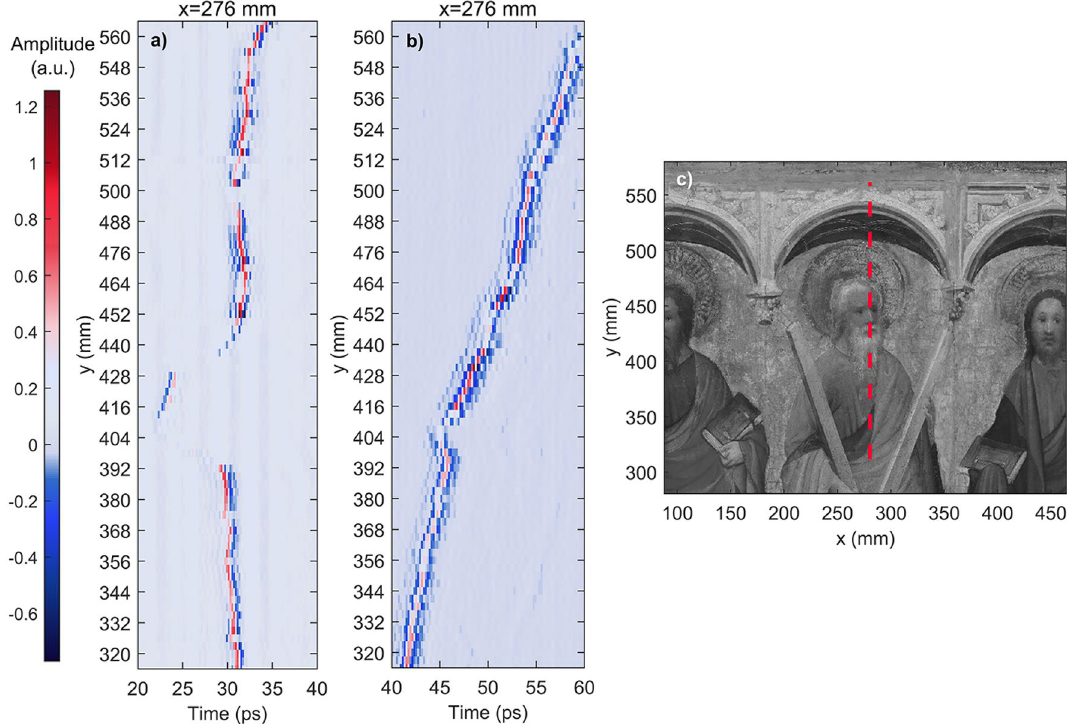
Figure 3. Comparison of before and after B-scans of ROI 2 at x = 276 mm. ( a ) B-scan along y-axis of the before data. Significant layer detachment is visible from y = 386 mm to y = 446 mm. Sub-surface air gaps are visible from y = 452 mm to y = 464 mm. ( b ) B-scan corresponding to the same region after the consolidation. The detached area between y = 386 mm and y = 446 mm has been consolidated, and appears homogeneous. Air voids are still present in the upper region along this line, as they were not consolidated. ( c ) Close up photograph of the region analyzed. The red dotted line shows the exact location on the x-axis where the data for the B-scans was